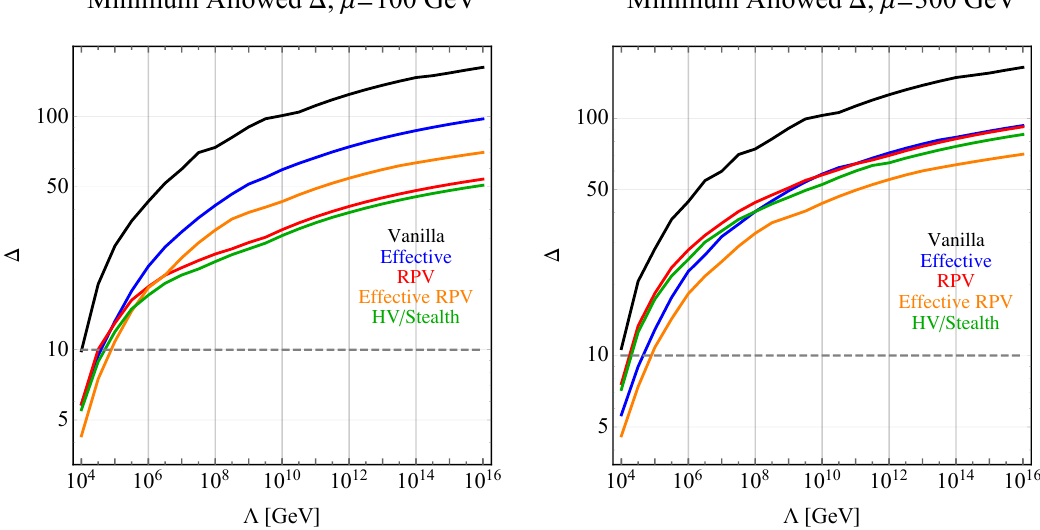
Figure 6 . Minimum amount of tuning (cid:1) which is experimentally allowed as a function of SUSY breaking scale